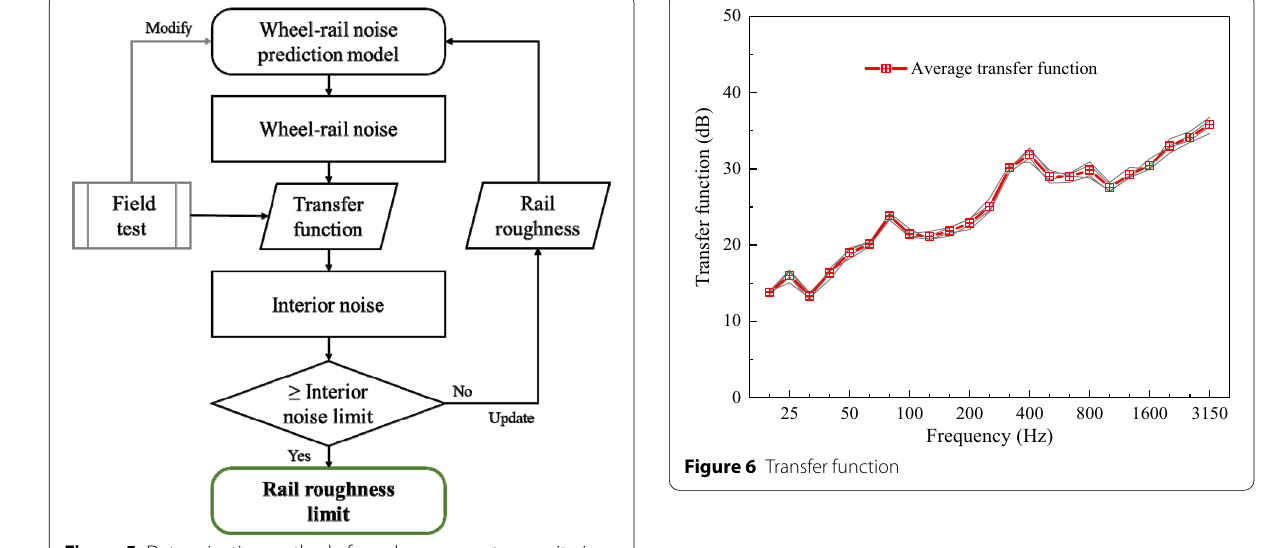
Figure 5 Determination method of roughness acceptance criteria